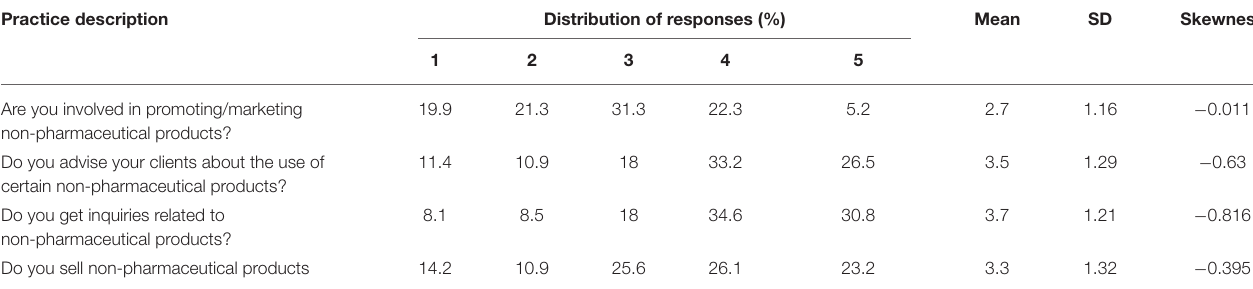
TABLE 4 | Distribution of community pharmacists’ practice toward non-pharmaceutical products from 1 (never) to 5 (always), n = 211. Practice